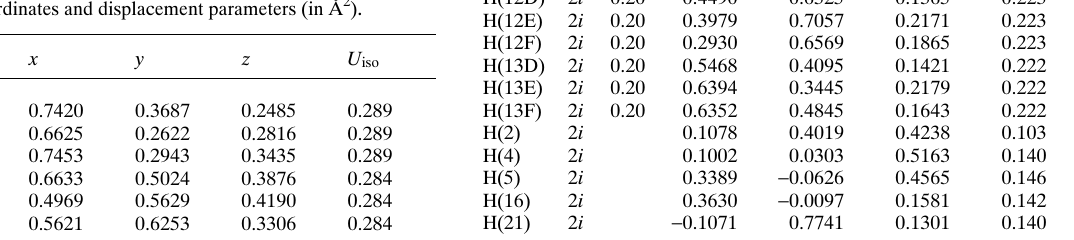
Table 2. Atomic coordinates and displacement parameters (in Å 2 ) .